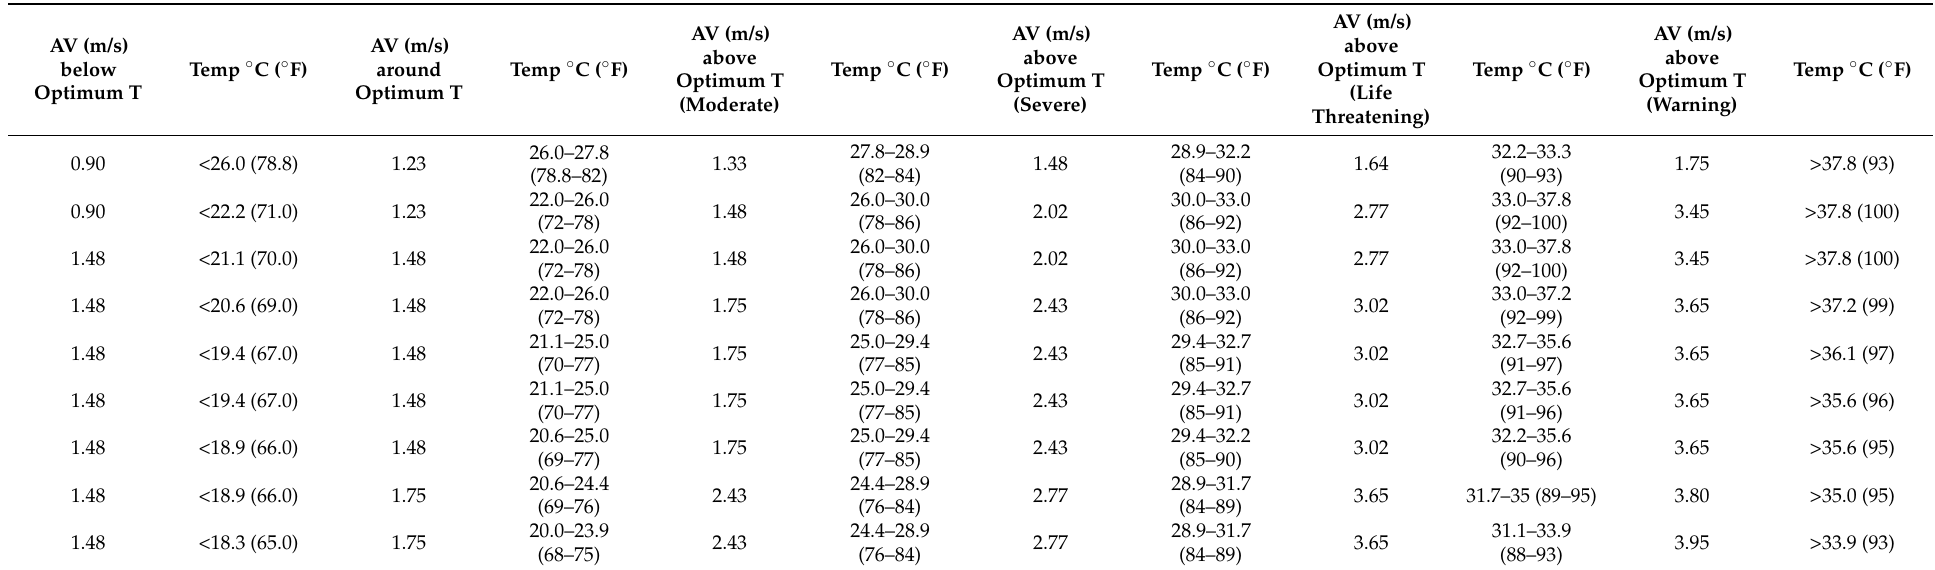
Table 2. Low AV treatment